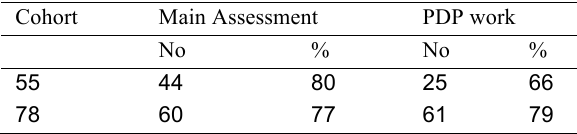
Table 2. Summary of Assessment Submission